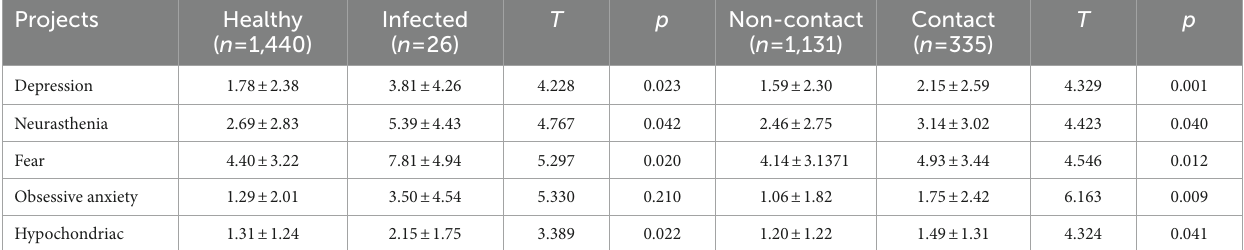
TABLE 2 Comparison of differences in emotional dimensions of one’s health status and whether or not there is a novel Coronavirus exposure history. Projects Healthy Infected ( n = 1,440) ( n = 26)